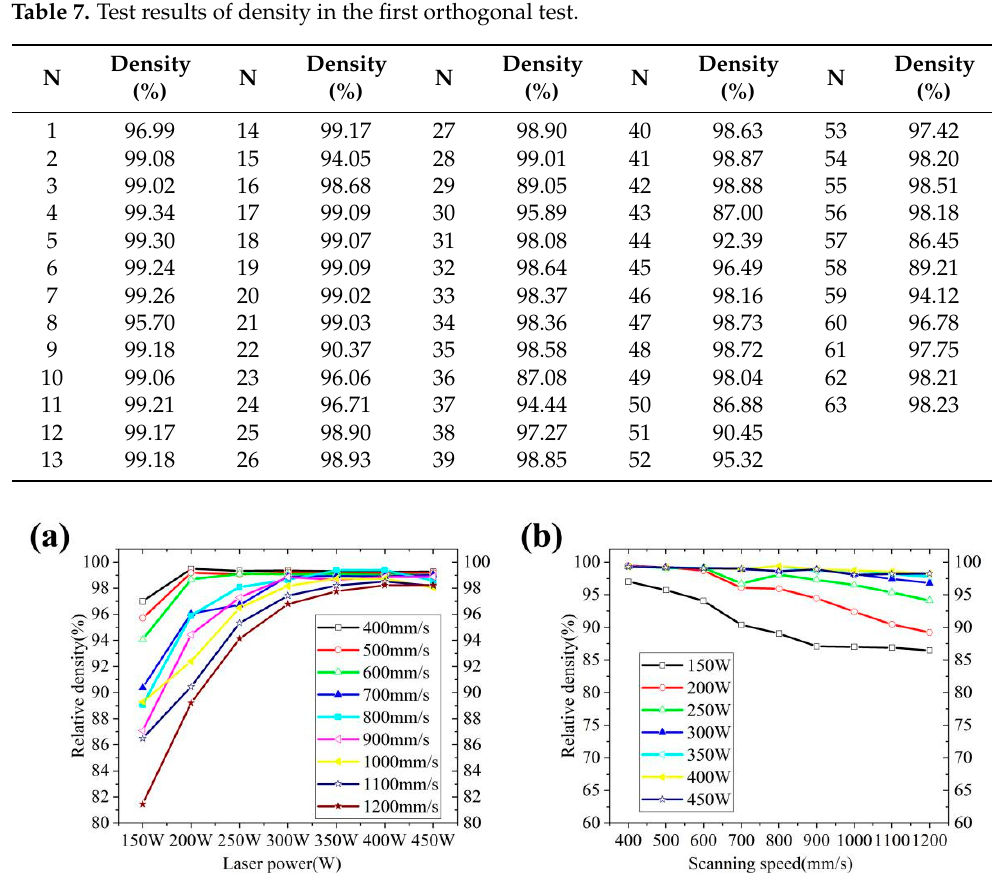
Figure 4. Effect of process parameters on density: ( a ) effect of laser power on density; ( b ) effect of scanning speed on density.